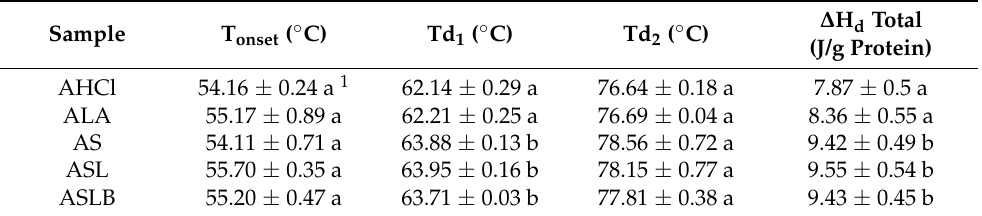
Table 2. Thermal parameters of albumin fractions obtained by lactic fermentation (AS, ASL, ASLB) and controls (AHCl,